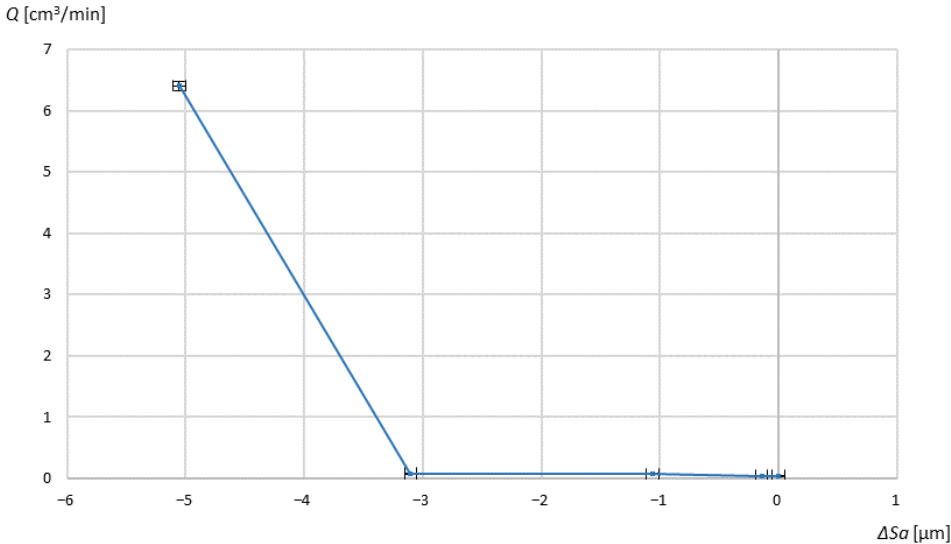
Figure 16. The value of leakage Q as a function of the difference in the value of the surface topogra- phy parameter Sa for a constant compressive force of 2280 N for the base surface with a value of Sa = 0.187 µm.